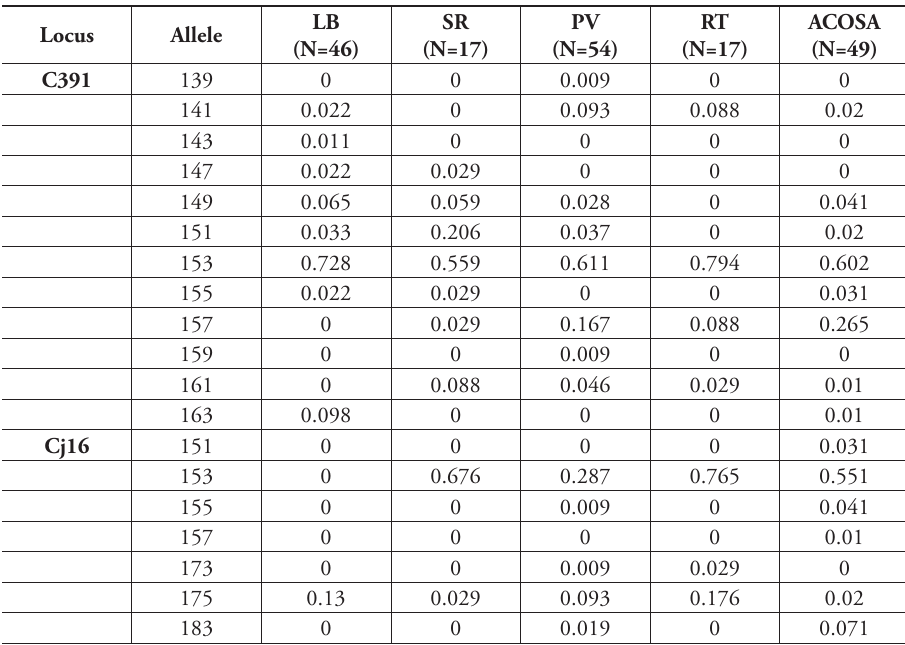
Allele Frequencies. Allele frequencies for each locus in each Crocodylus acutus population studied in Pacific Costa Rica. The number in parenthesis indicates the sample size in that